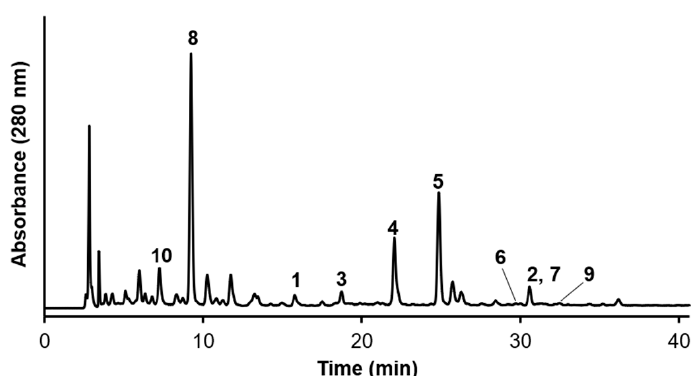
Figure 3. HPLC chromatogram of the ethanol extract of C. officinalis leaves; quercetin 3- O - β -gluco- side ( 1 ), isorhamnetin 3- O - β -glucoside ( 2 ), quercetin 3- O - β -neohesperidoside ( 3 ), quercetin 3- O -(2 ″ - O - α -rhamnosyl-6 ″ - O -malonyl)- β -glucoside ( 4 ), quercetin 3- O -(6 ″ - O -malonyl)- β -glucoside ( 5 ), quercetin 3- O -6 ″ - O -methylmalonyl)- β -glucoside ( 6 ), isorhamnetin 3- O -(6 ″ - O -malonyl)- β -glucoside ( 7 ), chlorogenic acid ( 8 ), 3,4-dicaffeoylquinic acid ( 9 ), and syringic acid ( 10 ).